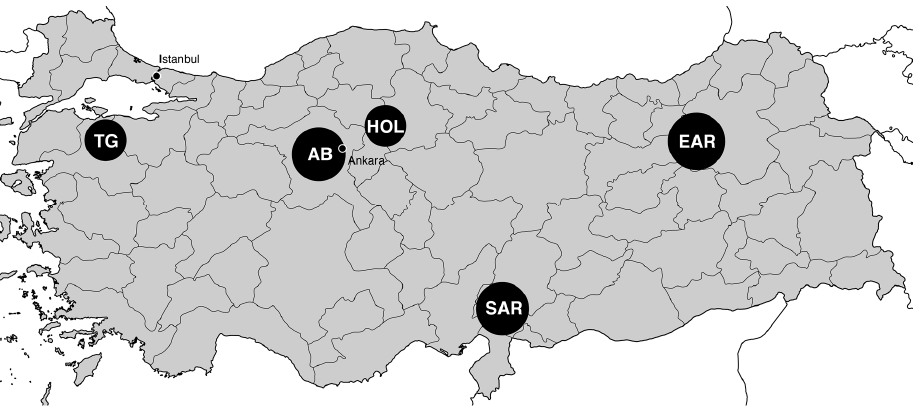
Figure 1. Geographical regions of the sampled breeds: Anatolian Black (AB), East Anatolian Red (EAR), South Anatolian Red (SAR), Turkish Grey (TG), and Holstein (HOL). Sizes of circles denote relative population sizes.